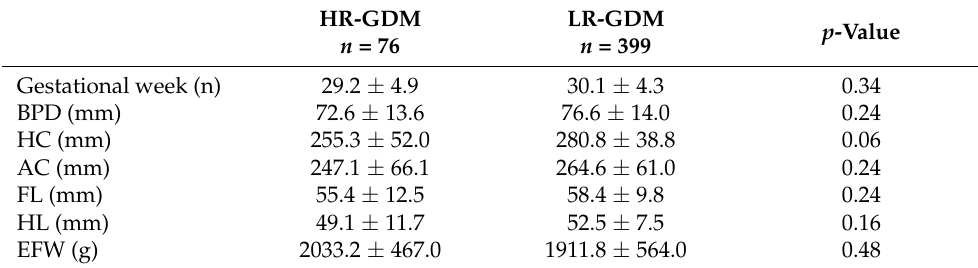
Table 3. Fetal ultrasound parameters (third trimester).